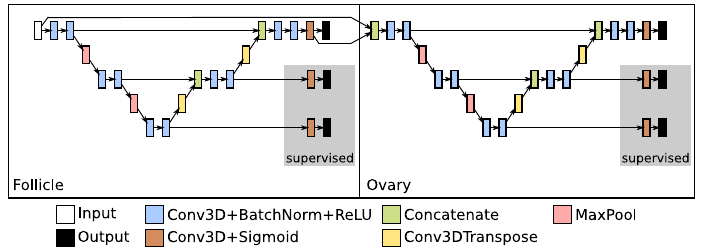
Figure 4. Example of the first proposed U-Net extension, EXT 1—two consecutive U-Nets: The segmentation map of the first stage is concatenated with the input and passed as the input to the second stage. The first stage detects follicles, while the second stage identifies the ovary. Deep Supervision outputs are shown in a grey